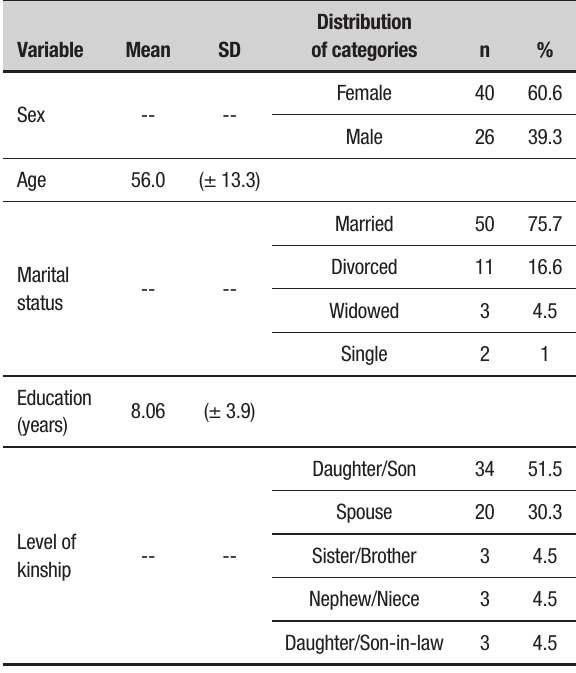
Table 1. Demographic characteristics of the family caregivers of elderly with AD (n=66). São Carlos, SP, Brazil. 2015.